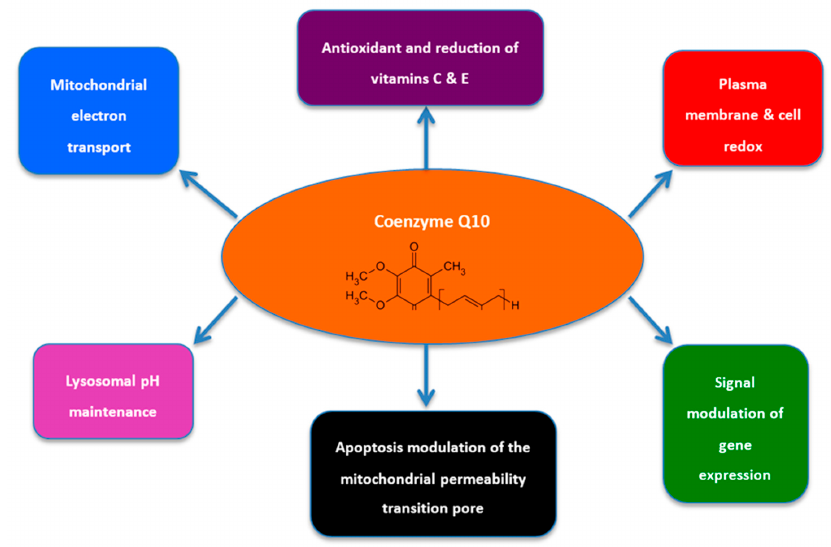
Figure 1. The intracellular roles of CoQ10 (adapted from De Barcelos and Haas, 2019 [16]).